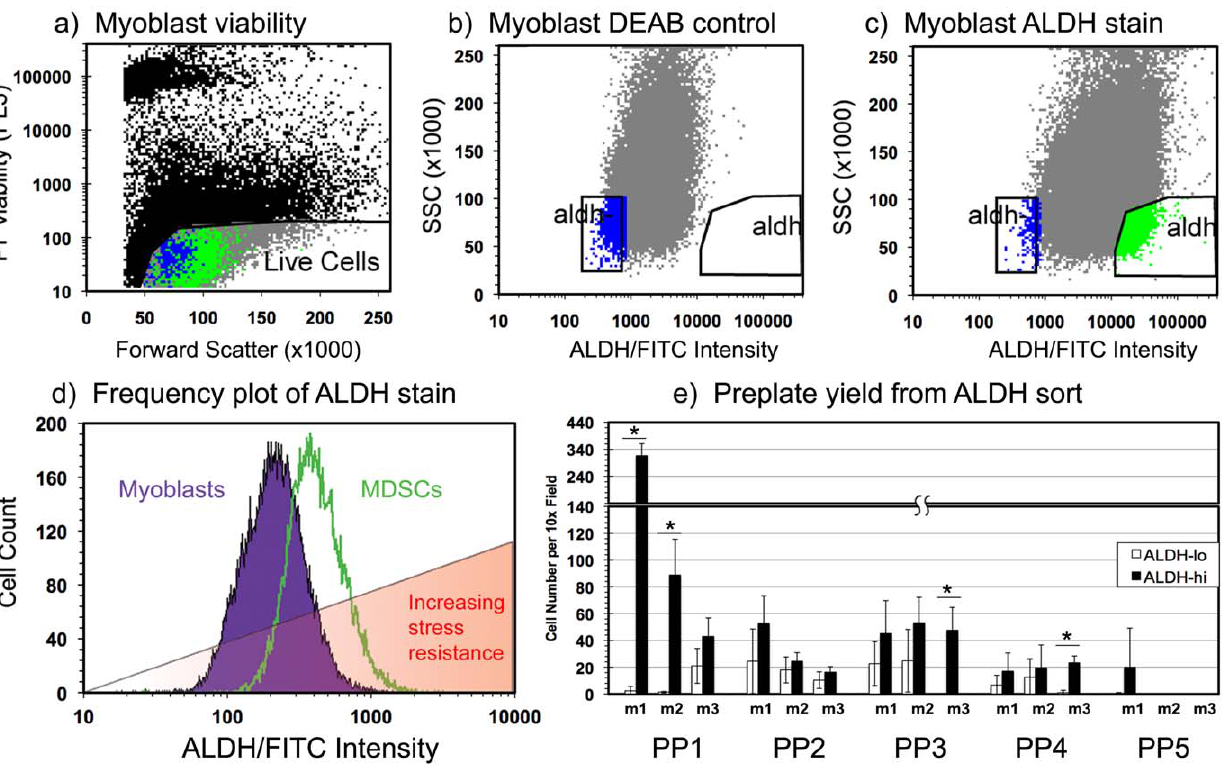
Figure 1. Fluorescence activated cell sorting (FACS) of muscle derived cells by aldehyde dehydrogenase activity. Isolation of ALDH lo and ALDH hi subpopulations from cultured myoblasts was performed using FACS. (a) Dead cells were excluded from the isolation by detection of nuclear propidium iodide fluorescence. (b, c) ALDH hi SCC lo (high ALDH activity, low side scatter) cells were isolated from a heterogeneous population of myoblasts using DEAB, a potent inhibitor of ALDH, as a gating control. (d) Measurement of the FITC channel signal intensity of Aldefluor stained murine myoblasts and MDSCs demonstrated a shift in the distribution of signal intensity between the two populations, suggesting an increase in the median ALDH activity in MDSCs compared to myoblasts. (e) ALDH sorted murine muscle derived cells were preplated to demonstrate the increased yield of cells in later preplate cycles from ALDH hi cells (up to PP5) compared to ALDH lo cells. Cells were isolated from three mice labeled m1, m2, and m3. (* indicates p ,